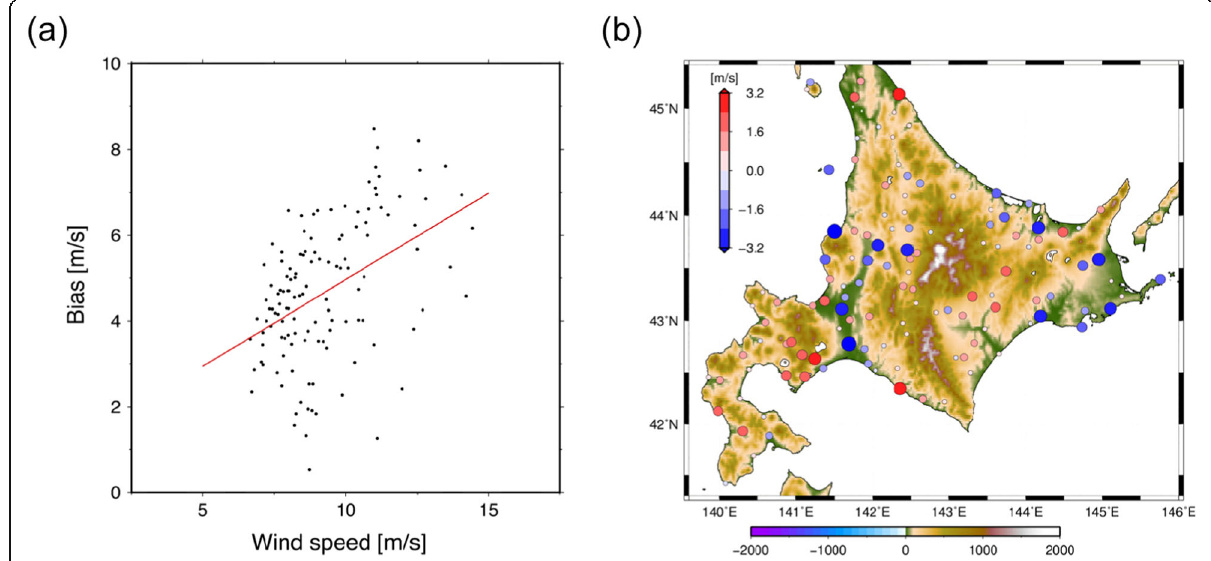
Fig. 3 The characteristics of the wind speed bias. a The relationship between the wind speed bias against the simulated mean wind speed. The linear regression line is indicated by red line. b The difference of the wind speed bias at each station against the spatially averaged bias over all the stations in Hokkaido. The color shading in ( b ) indicates the ground elevation